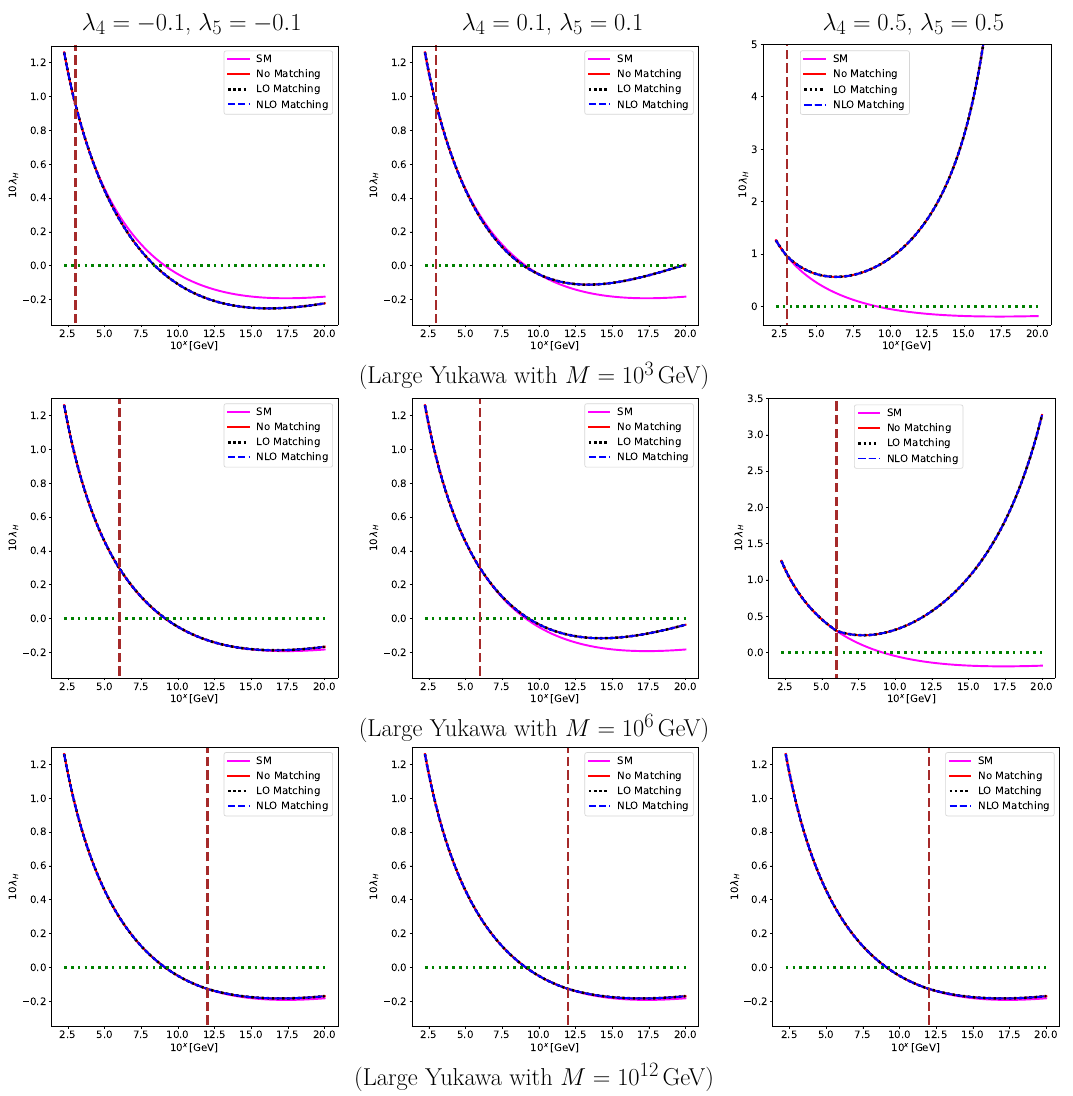
Figure 10 . Same as figure 8 but for the running of λ H